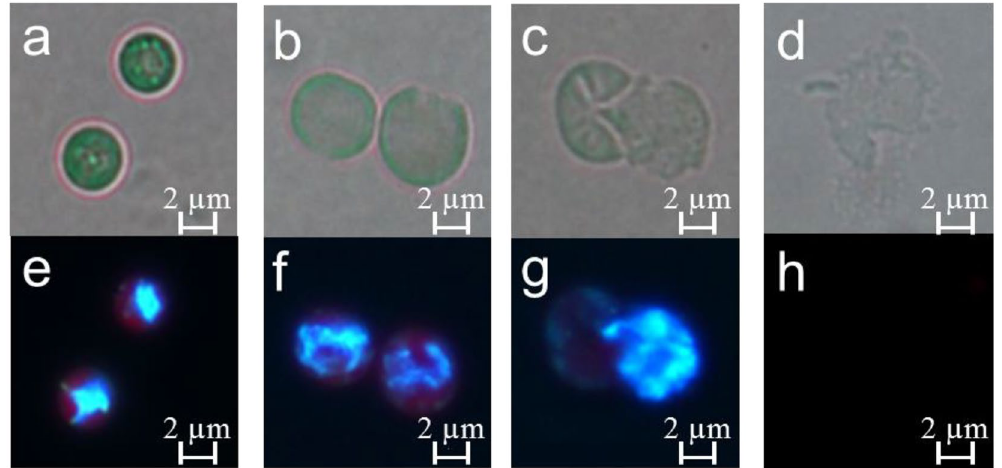
Figure 2. The effects of PG on cell morphology and nucleoids of M. aeruginosa . Algal cells were harvested by centrifugation after being exposed to PG for 0 ( a , e ), 24 ( b , f ), 48 ( c , g ) and 72 h ( d , h ) and were stained with DAPI (5 µ g/mL) for 5 min in the dark at room temperature, and observed by fluorescence